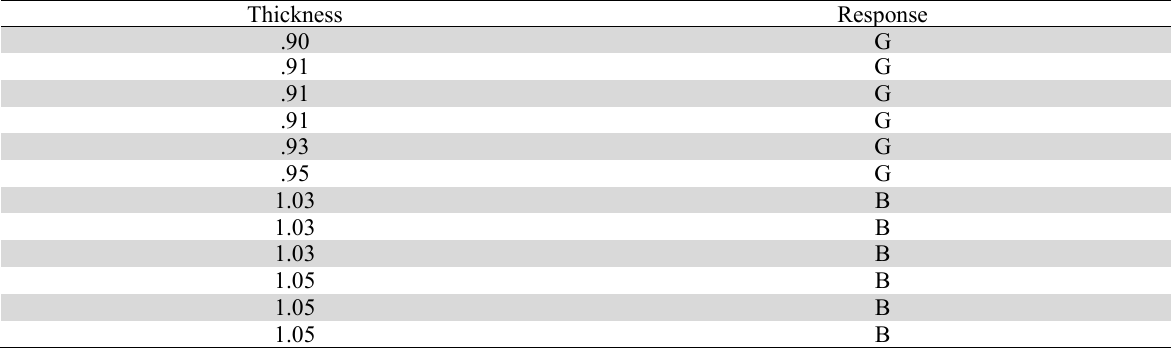
Paired Comparison Thickness Response .90